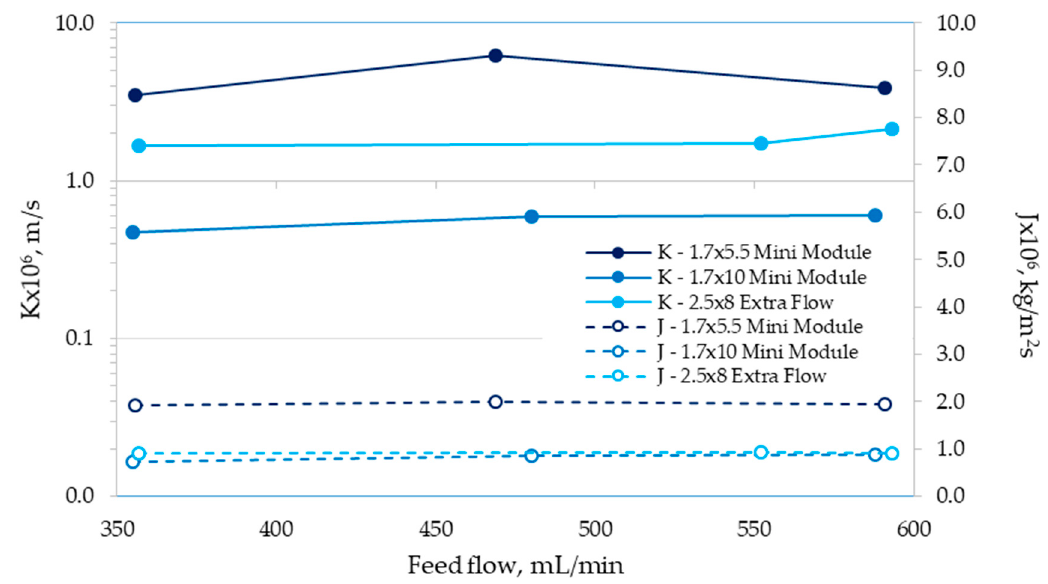
Figure 4. Overall mass-transfer coefficient (K) and flux of HCN at 60 min (J) for each HFMC module operated at different feed flows.